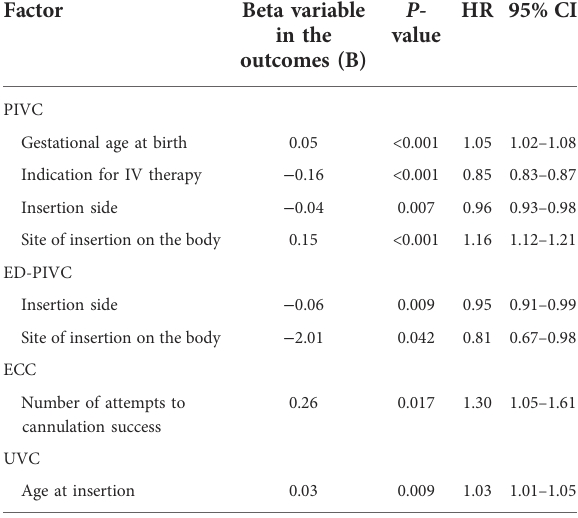
TABLE 4 Multivariable Cox regression analyses regarding the type of catheter